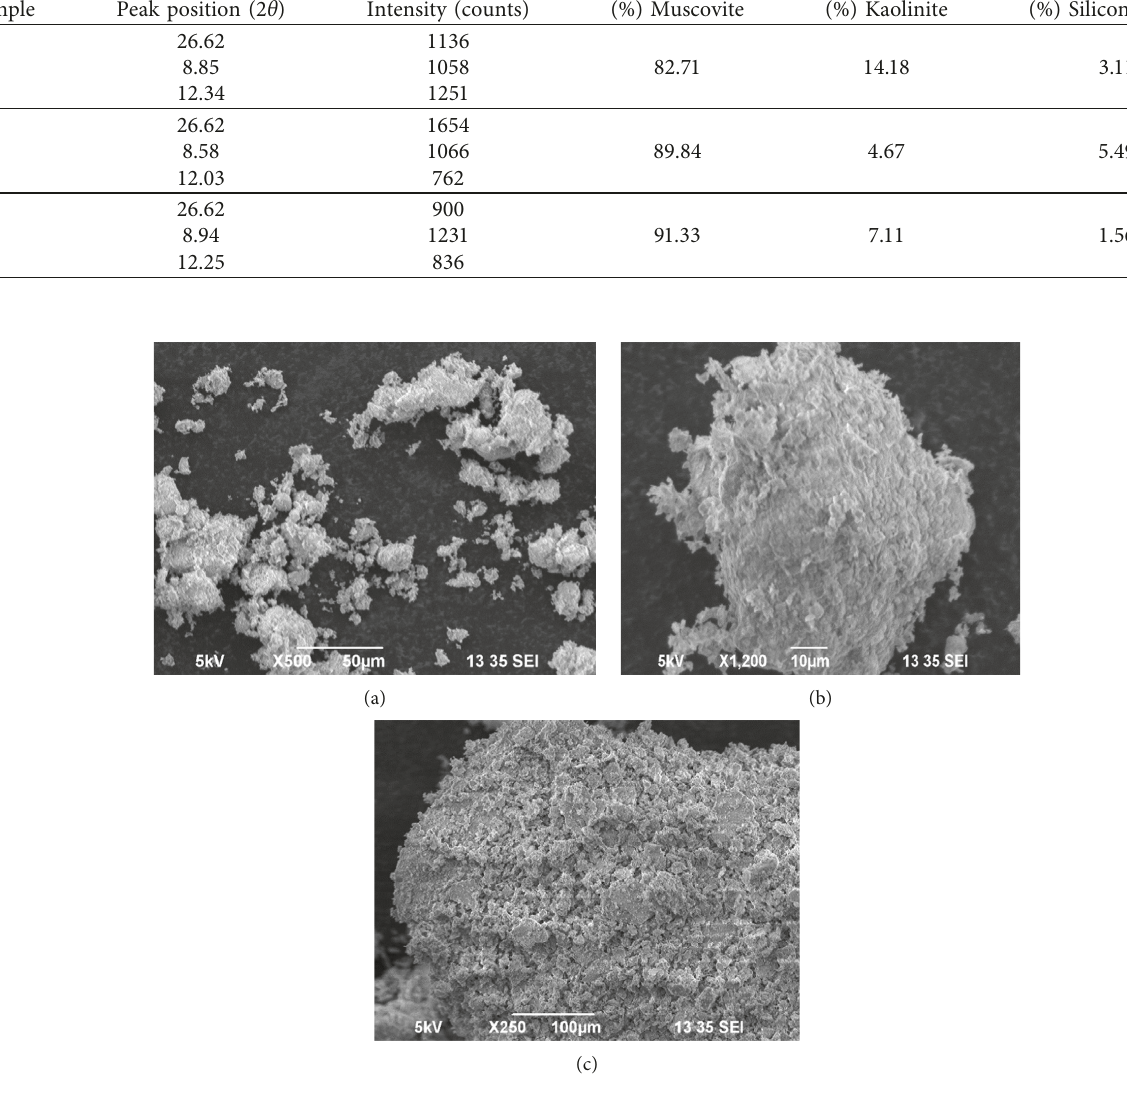
Figure 2: SEM micrographs of the clay samples. (a) E1, (b) C1, and (c)